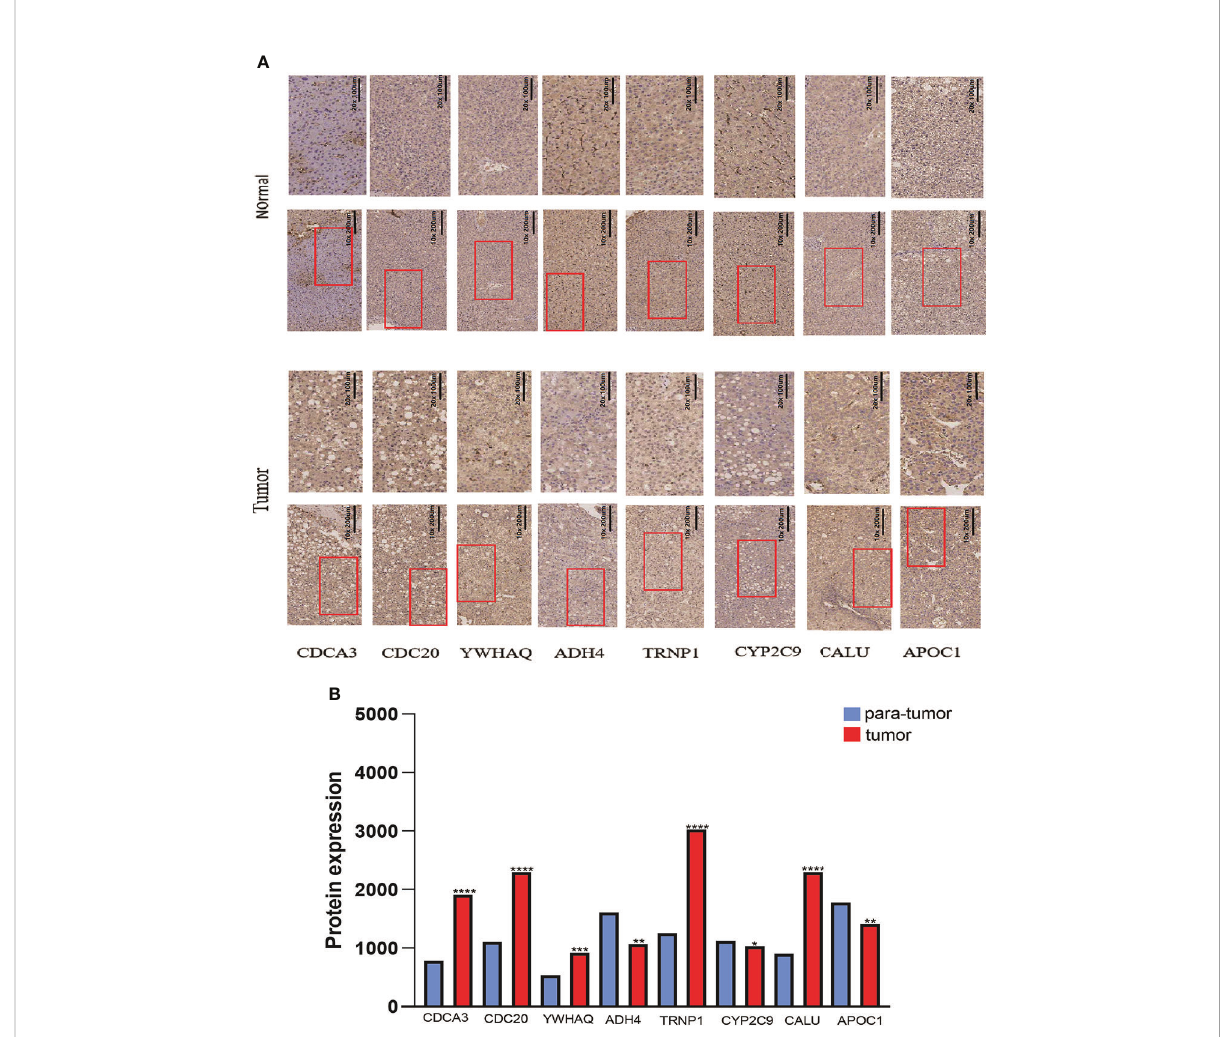
FIGURE 12 The protein expression levels of 8 DMRegs of prognostic signature in hepatocellular carcinoma tissues and corresponding normal tissues by